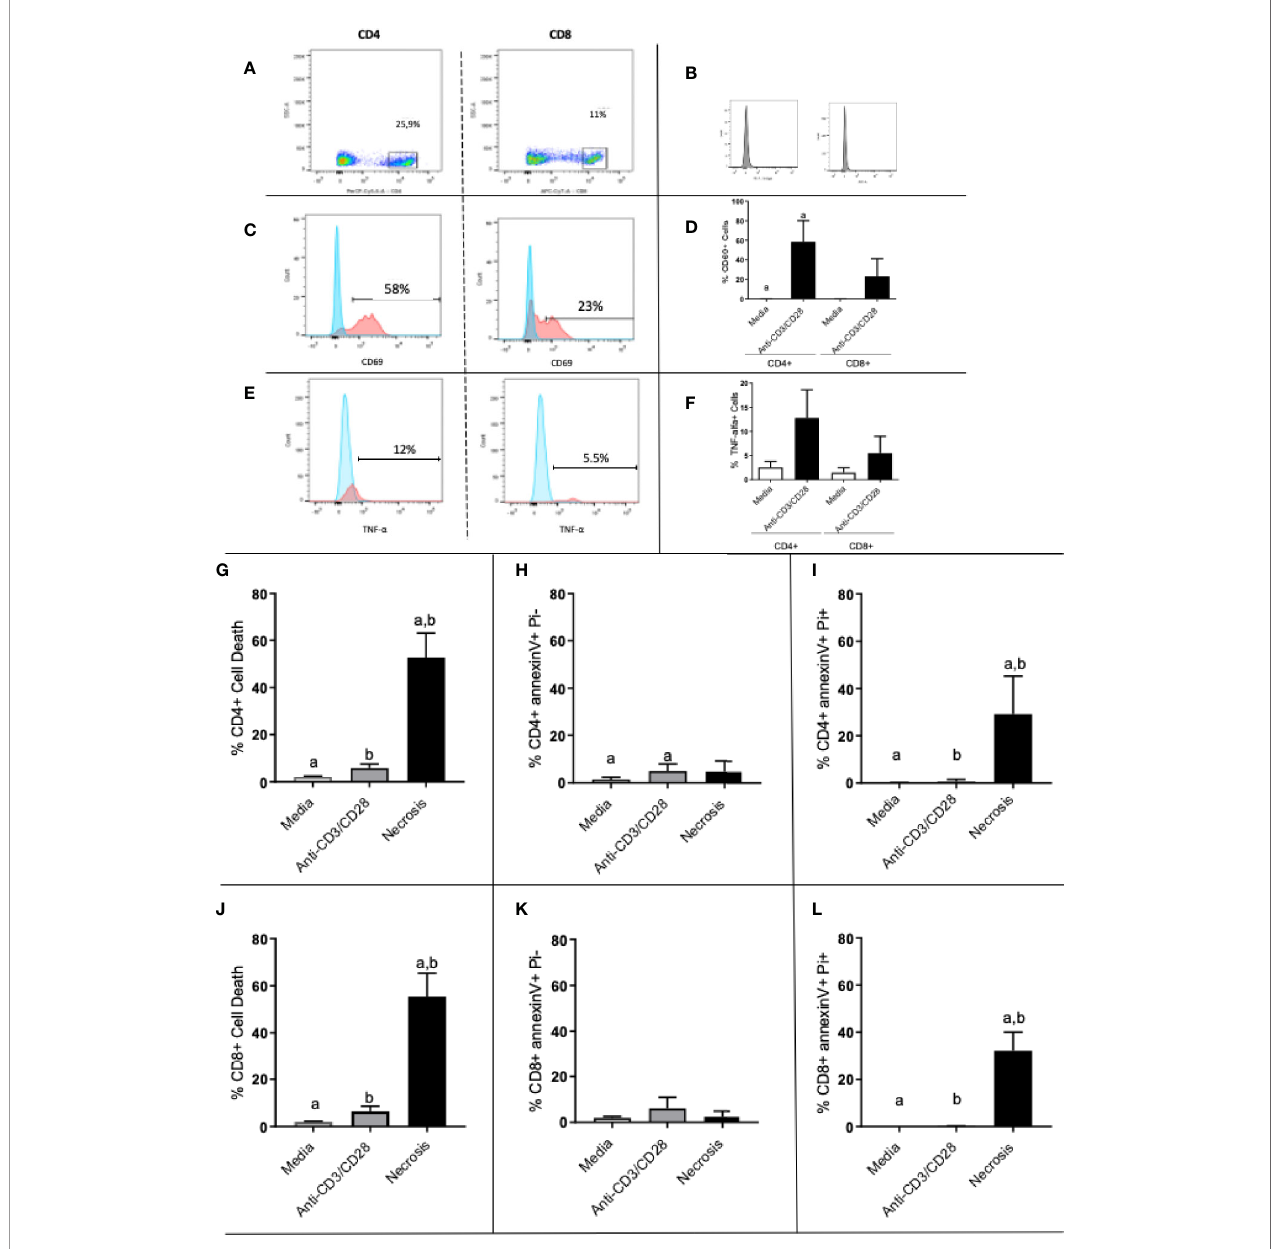
FIGURE 5 | Evaluation of activation and death of CD4+ and CD8+ T cells. (A) Gate selection for CD4+ and CD8+ analysis; (B) isotype controls; (C, E) representative histograms for CD69 and TNF analysis, respectively, in CD4 and CD8 cells, as indicated. Expression of CD69 and (D) TNF (F) by CD4+ and CD8+ T lymphocytes before and after stimulation with anti-CD3/anti-CD28. (G – I) show total death, early apoptosis and late apoptosis of CD4+ T cells, respectively. (J, L) show total death, early apoptosis and late apoptosis of CD8+ T cells, respectively. Data is presented as average per group ± standard error of the mean and presence of the same letters in different bars represents statistically signi fi cant differences between them